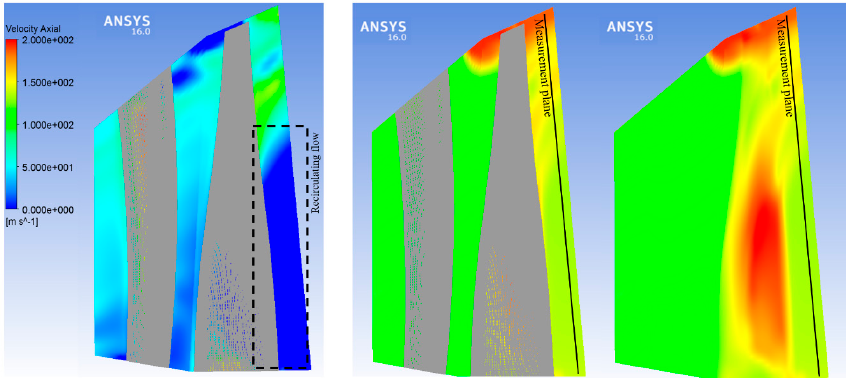
Figure 7. Test Case 2—calculated axial velocity and flow temperature field.